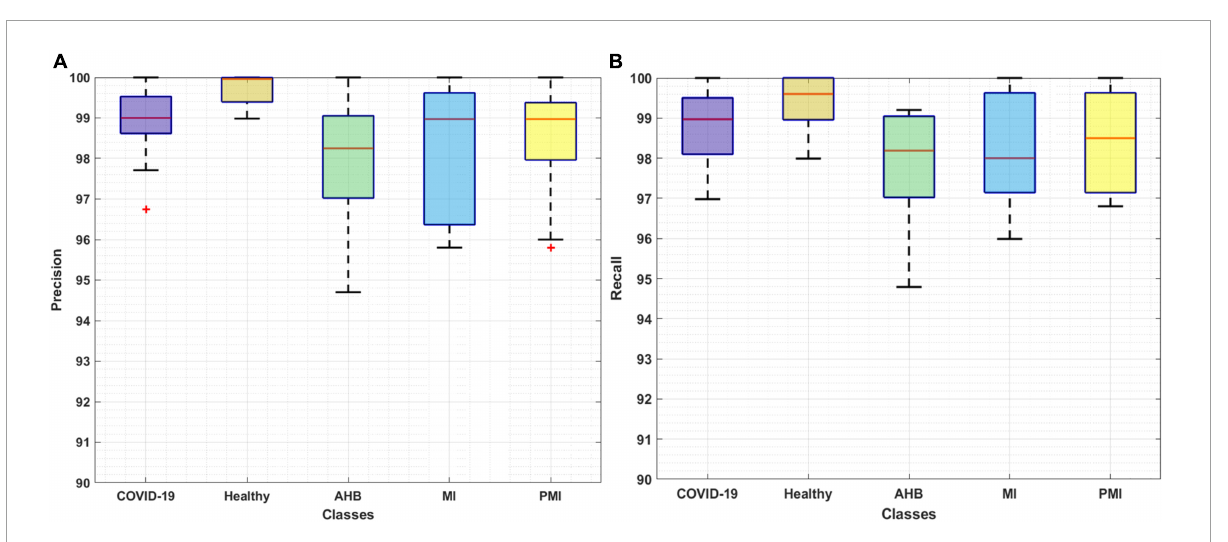
FIGURE6 Evaluation of proposed method through (A) Precision and (B)